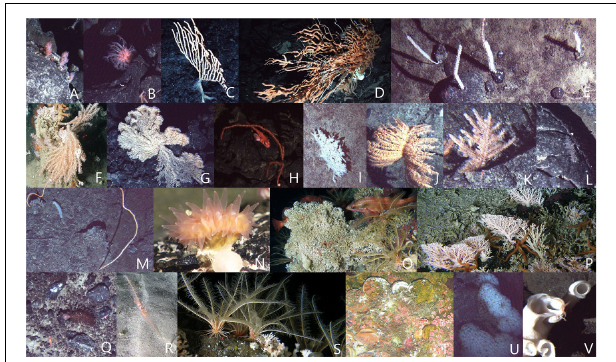
FIGURE 3 | Representative photographs of the 19 groupings of habitat-forming biological structures on Cobb Seamount, observed during the 2012 visual survey. The listed taxa are vulnerable marine ecosystem (VME) indicators according to one or more regional fisheries management organizations (RFMOs; see Table 1 ). The Alcyonacea soft corals (A) Gersemia sp., (B) Heteropolypus ritteri , (C) Isidella tentaculum , (D) Keratoisis sp. A, (E) Keratoisis sp. B, (F) Primnoa pacifica , (G) Plumarella superba , and (H) Swiftia simplex . The Antipatharia black corals (I) Chrysopathes speciosa , (J) Bathypathes sp., (K) Lillipathes lillei , (L) Antipatharia sp., and (M) Stichopathes sp. The Scleractinia stony corals (N)